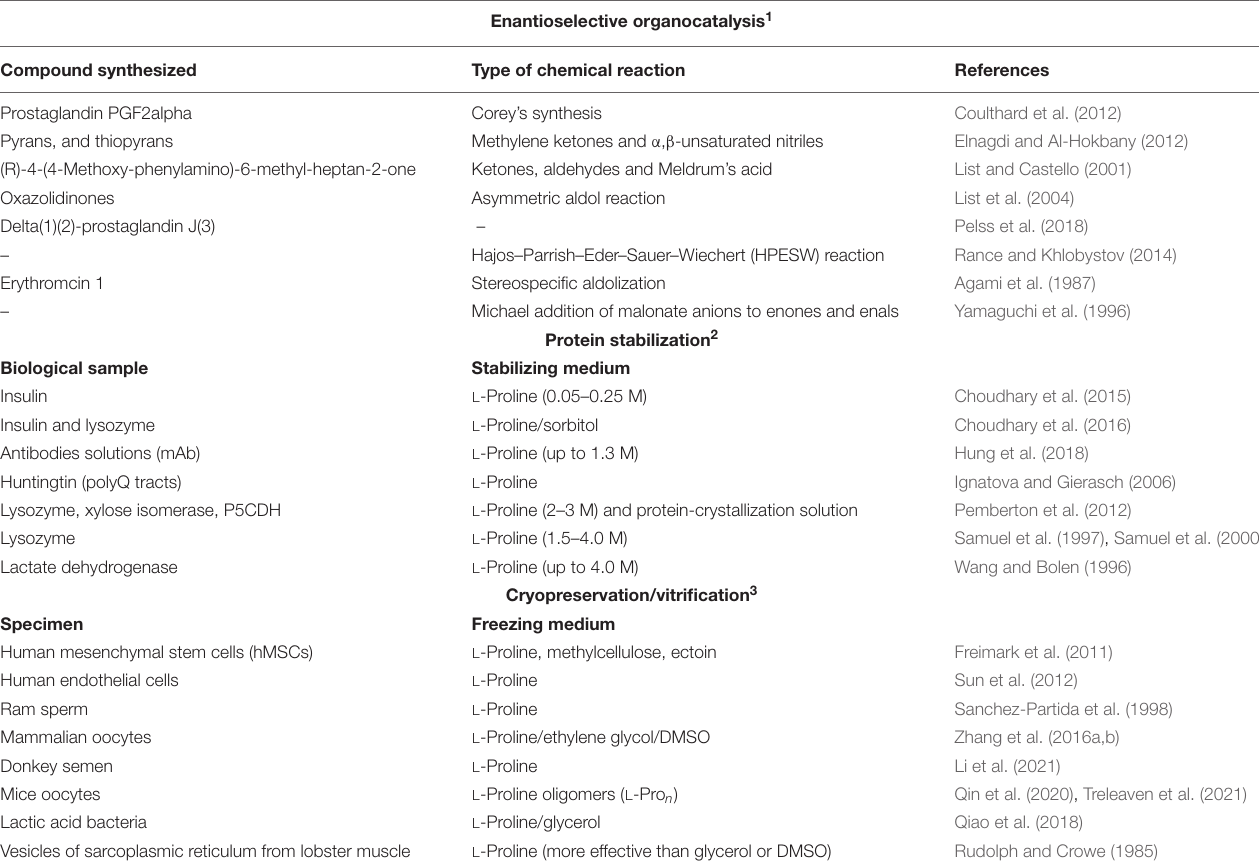
TABLE 1 | Proline in drug synthesis, protein stabilization and